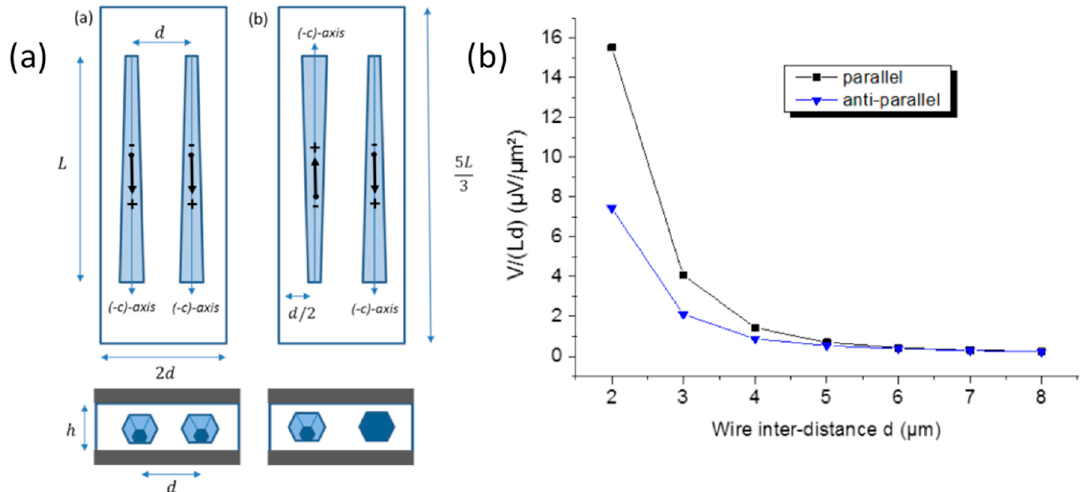
Figure 11. ( a ) Schematics of the wire relative crystallographic orientation: ( a ) parallel and ( b ) anti-parallel configurations of the c growth axis. The m-planes of GaN are parallel to the bottom electrode. The black arrows in the center of the wires are the in-plane representations of the equivalent electric dipoles schematized in Figure 7. ( b ) Potential per surface area measured between metal electrodes as function of wire inter-distance d for parallel and anti-parallel configuration of the wire orientation. A bending deformation of 10 cm curvature radius is applied to the bottom part of the simulated structure.